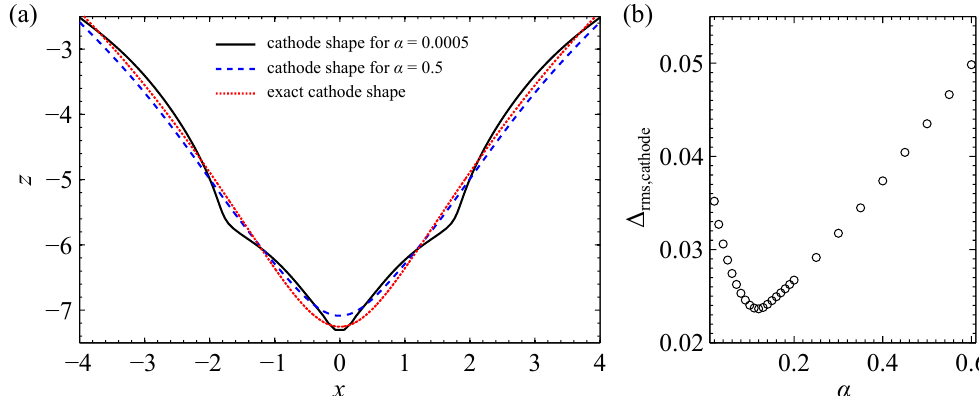
Figure 11. Influence of the regularization parameter α on the computed cathode shape (spatial dimensions are normalized to the width of the standard equilibrium front gap). The prescribed anode is the cubic spline connecting 13 control points shown in Figure 9. Panel ( a ) shows the region around the vertex of the cathode (cf. Figure 9a). Panel ( b ) shows the mean normal deviation of the numerically computed cathode from the analytical solution (see Equation (35)) as a function of α .